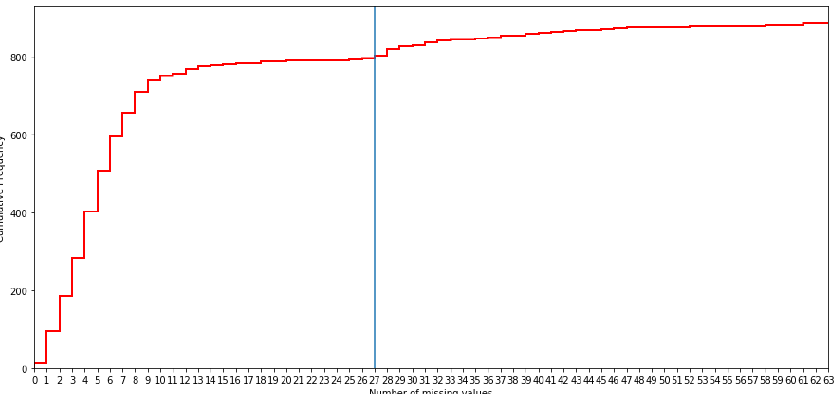
Figure 2. Cumulative histogram of the number of missing values by